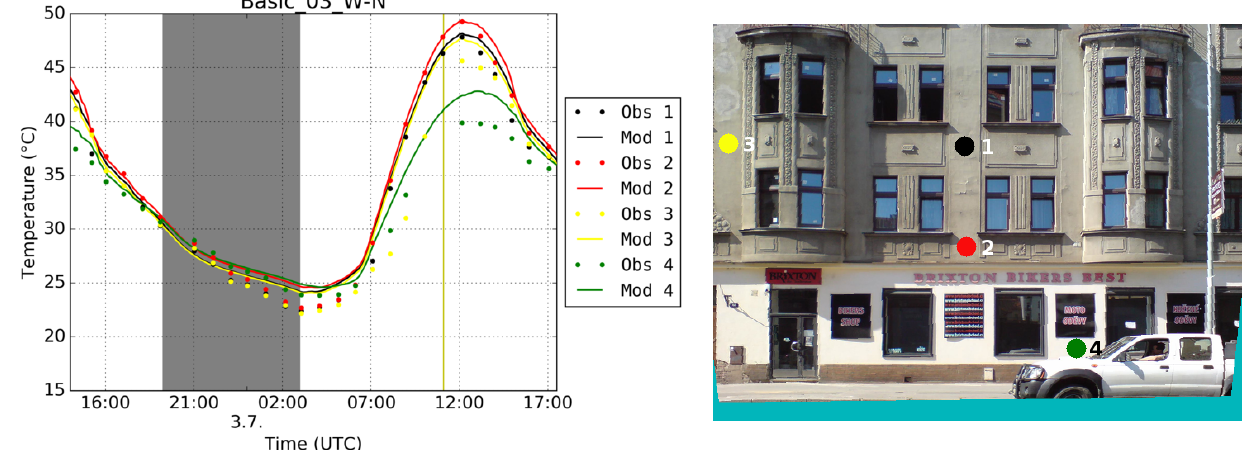
Figure 9. Comparison of modelled and observed surface temperatures from observation location 3 (50.10354 ◦ N, 14.45006 ◦ E) – view of the south-facing wall. The graph shows comparisons for selected evaluation points for the period of the observation campaign from 2 July 2015, 14:00UTC to 3 July 2015, 17:00UTC. The solid line represents modelled values, while the dots show the observed values. The shaded area depicts nighttime and the yellow vertical line depicts solar noon.